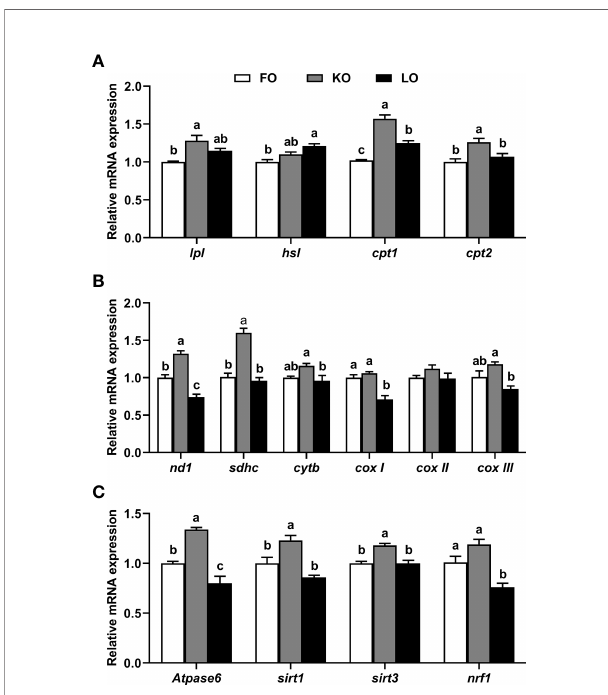
FIGURE 5 | Effects of dietary n-3 PUFA lipid sources on the expression levels of genes related to lipolysis (A) , electron transport chain complexes (B) and energy metabolism (C) in the hepatopancreas of swimming crab ( Portunus trituberculatus ). Values are mean ± SE (n = 4). Bars with different superscripts represent signi fi cant difference by one-factor ANOVA followed by a Tukey ’ s multiple range post-hoc test ( P < 0.05). Atpase6 , ATP synthase 6; cox I , cytochrome c oxidase subunit I; cox II , cytochrome c oxidase subunit II; cox III , cytochrome c oxidase subunit III; cpt , carnitine palmitoyltransferase; cytb , cytochrome b ; hsl , hormone-sensitive lipase; lpl , lipoprotein lipase; nd1 , NADH dehydrogenase subunit 1; nrf1 , nuclear respiratory factor 1; sdhc , succinate dehydrogenase subunit c; sirt , silent information